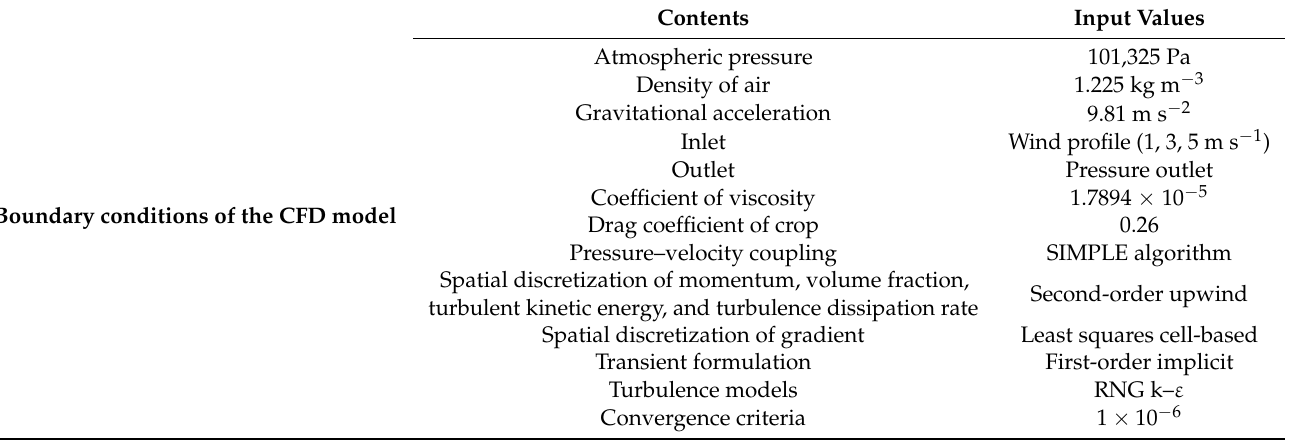
Table 1. Boundary condition of CFD model of evaluating ventilation characteristics of the